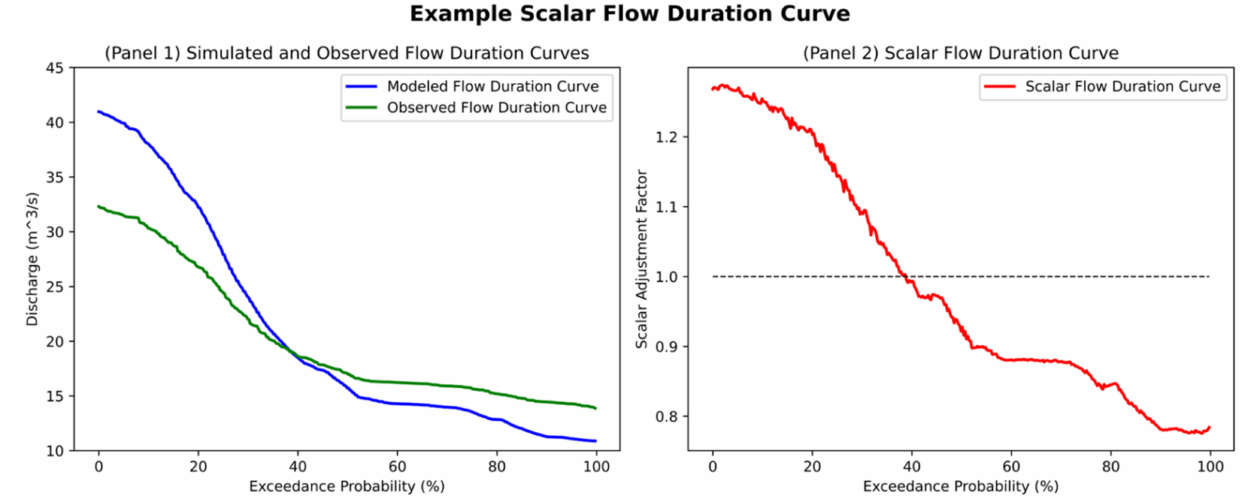
Figure 2. Sample calculation of the scalar flow duration curve using observed and simulated flow duration curves from the same